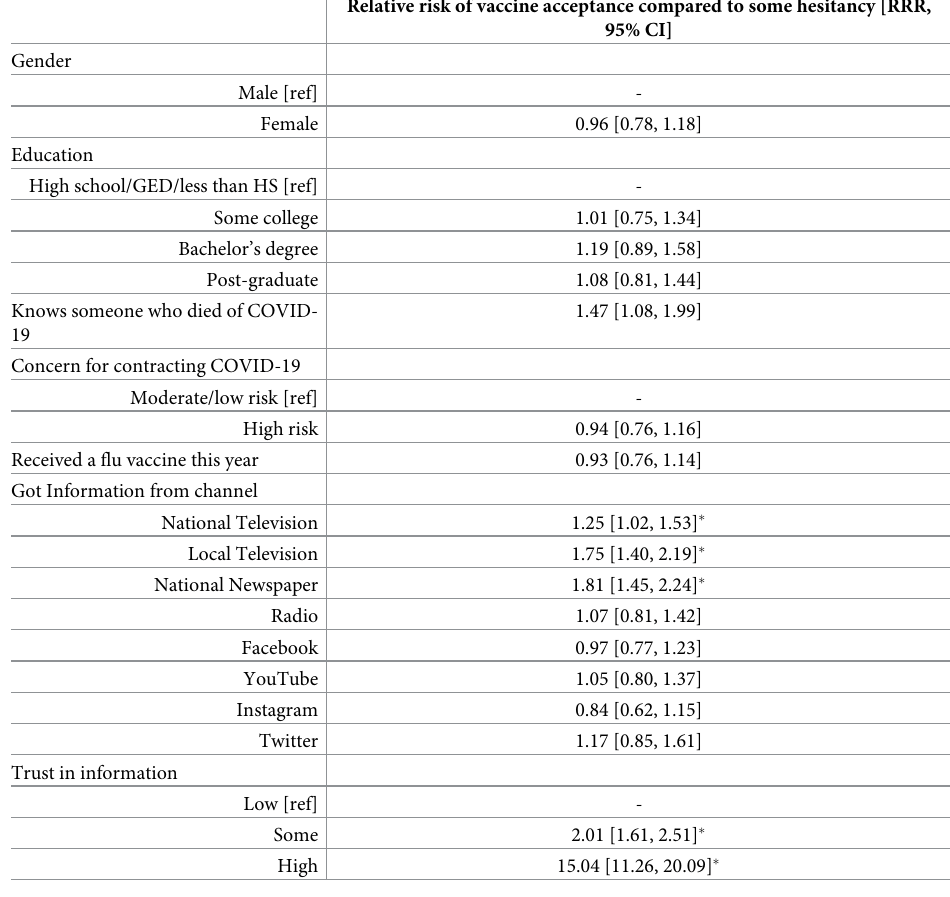
Table 3. Multivariable multinomial regression of vaccine